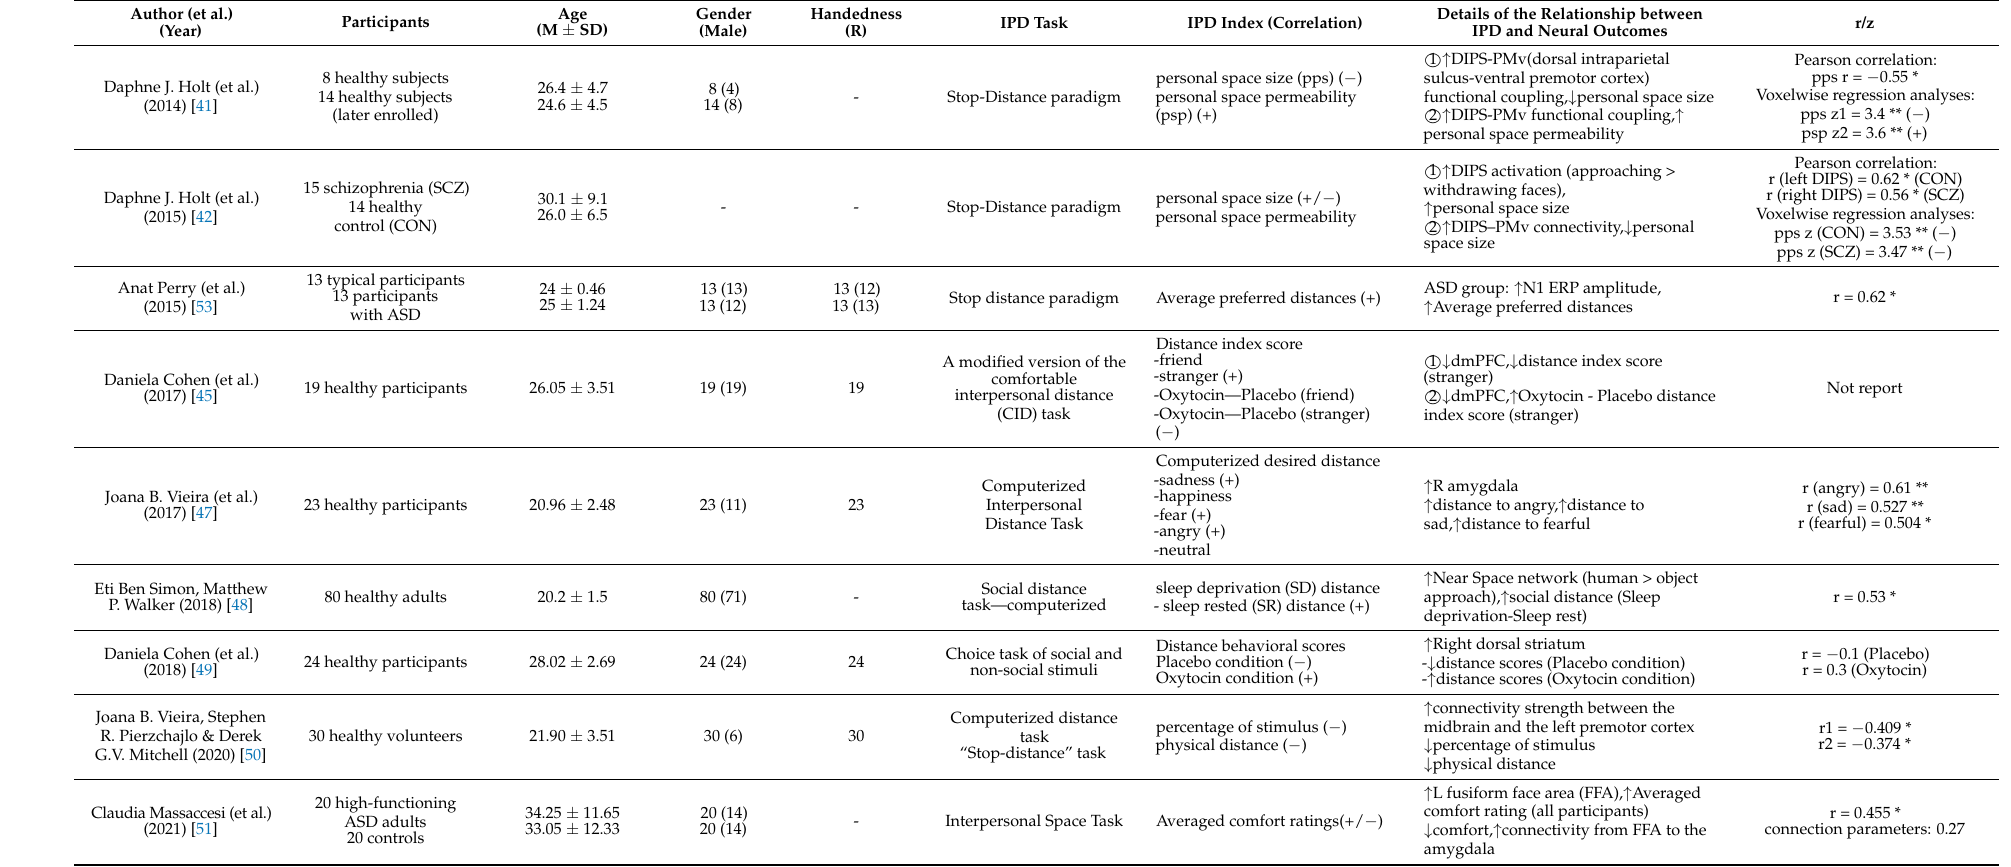
Table 3. IPD outcomes and their relationship with neural outcomes for the included